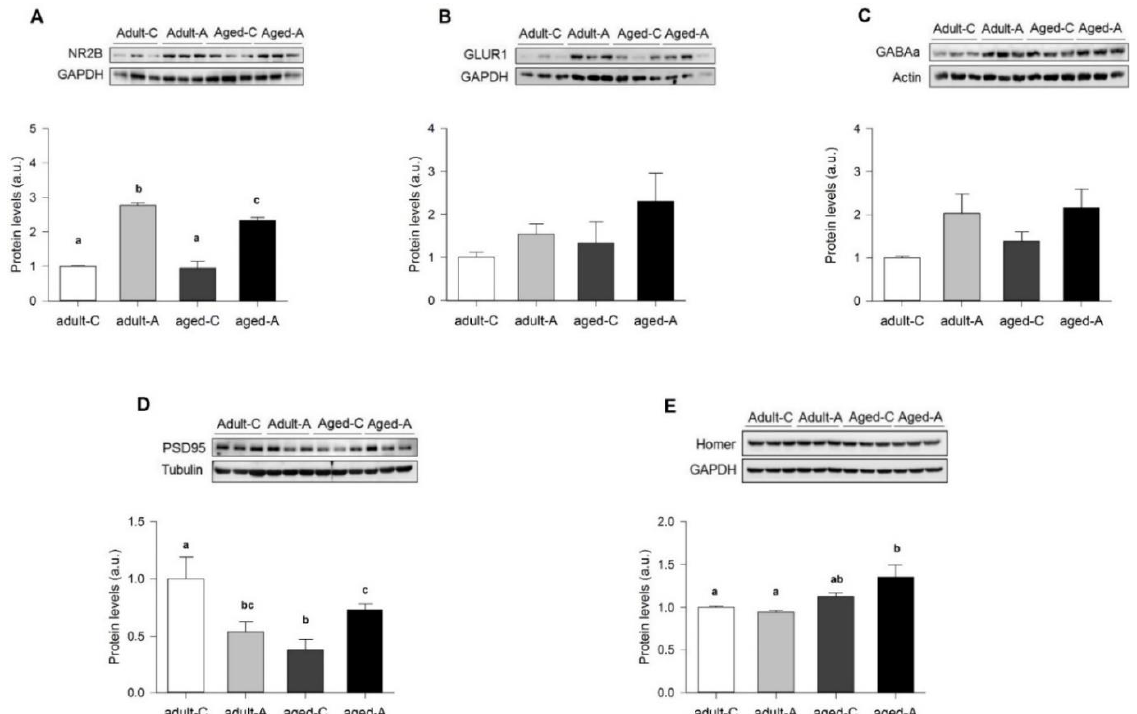
Figure 8. Differential effect of long-term ANDRO administration in the hippocampal postsynaptic protein of adult and aged female degus. Densitometric analysis of postsynaptic proteins: ( A ) NR2B, ( B ) GLUR1, ( C ) GABAA, ( D ) PSD95, and ( E ) Homer of adult (36 months old) and aged (72 months old) control (C) and ANDRO (A) female degus. Data were analyzed statistically using one-way ANOVA, with the p -value indicated at the top of each figure. Different letters above bars show statistical differences between the same protein across the ANDRO treatments (Fisher’s LSD post hoc test). Results are expressed as mean ± SE (n = 3); a.u: arbitrary units.